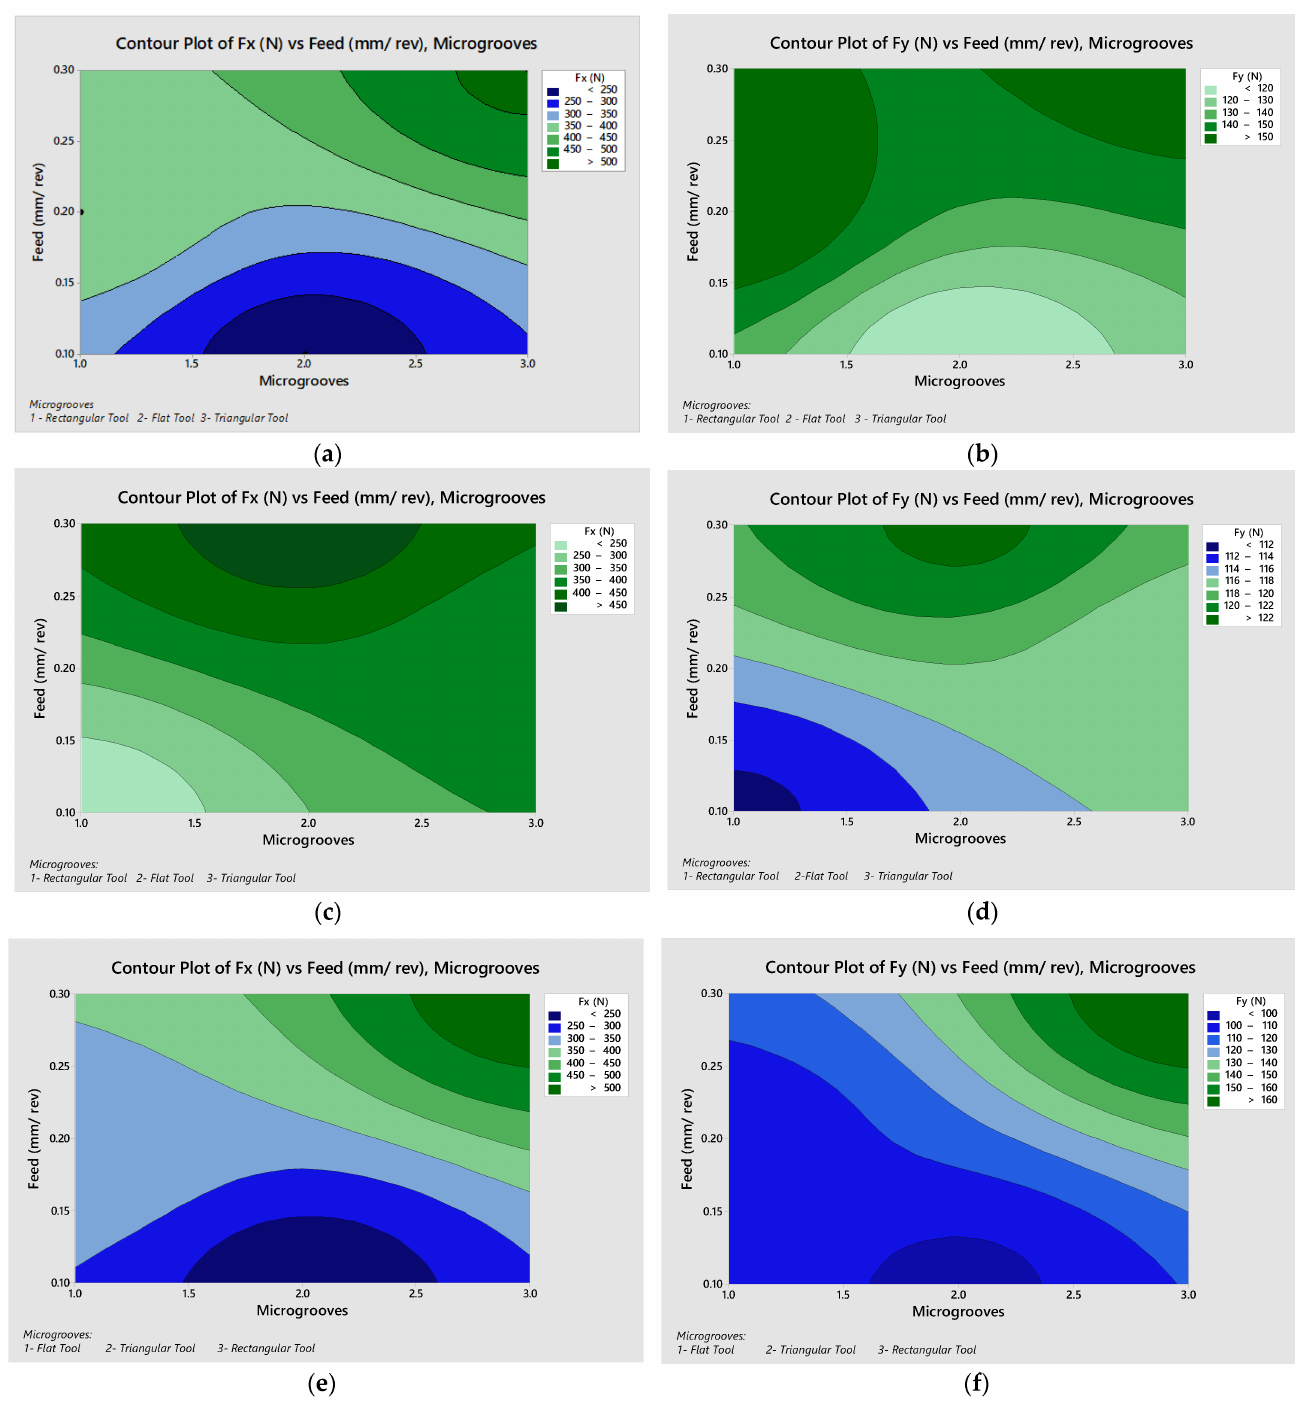
Figure 8. Contour plots for the cutting force components: ( a ) Fx —Microgrooves vs. Feed rate